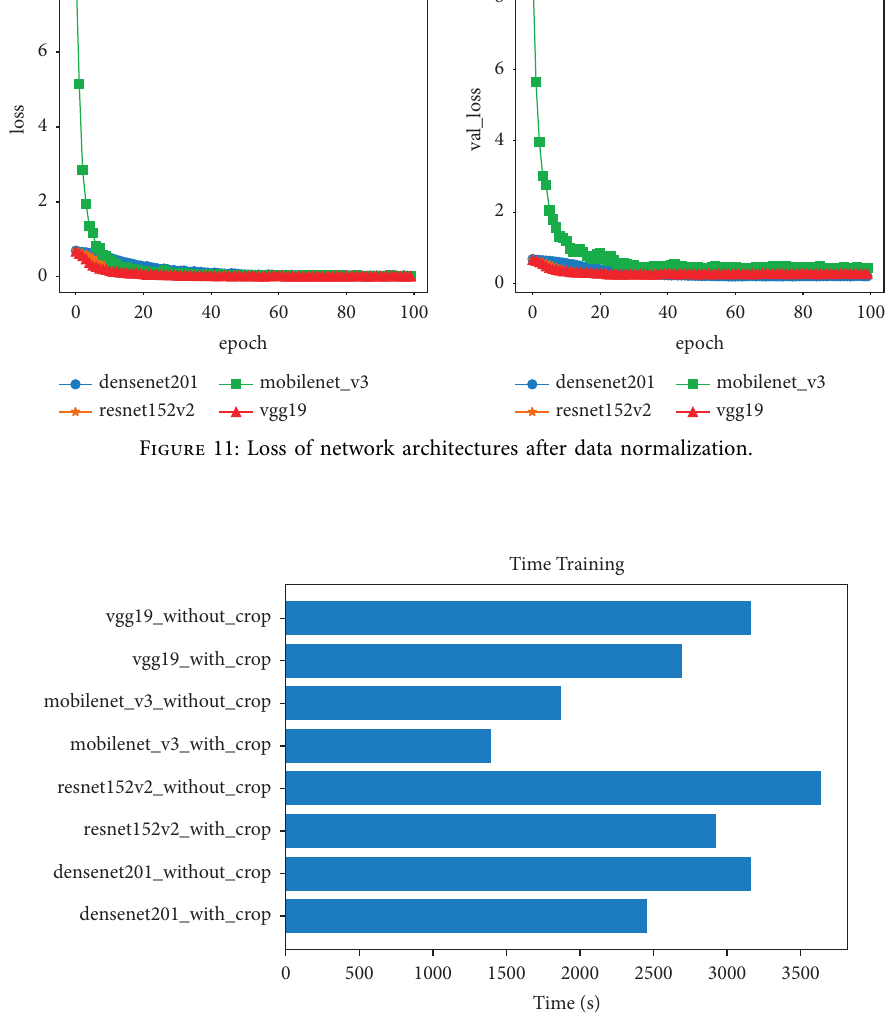
Figure 12: Training time over 100 epochs of network architectures before and after normalization. Table 4: Table of comparison results between algorithms before and after data